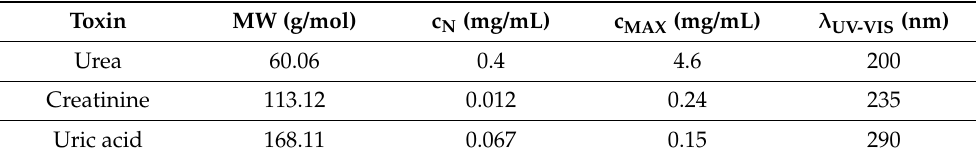
Table 1. Properties of the most abundant uremic toxins in blood. Toxin MW (g/mol) c N (mg/mL) c MAX (mg/mL) λ UV-VIS (nm) Urea 60.06 0.4 Creatinine 113.12 0.012 Uric acid